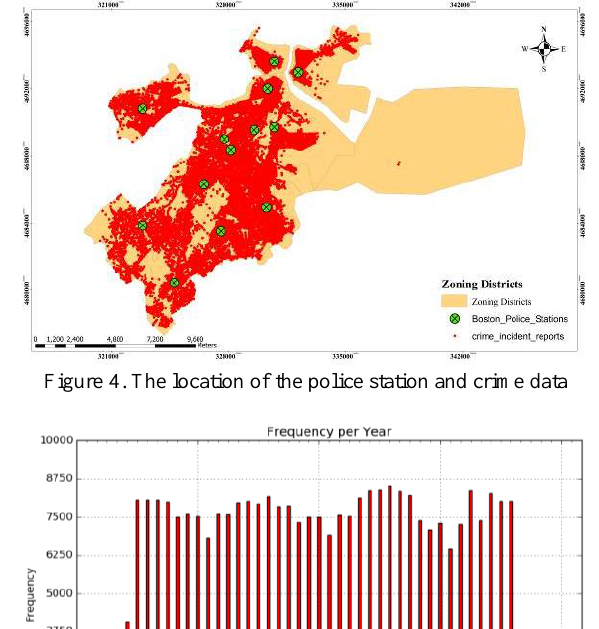
Figure 5. Crime temporal distribution (monthly), Boston, 06- 2015 to 08-2017 Figure 7 indicates the result of the GWR model based on